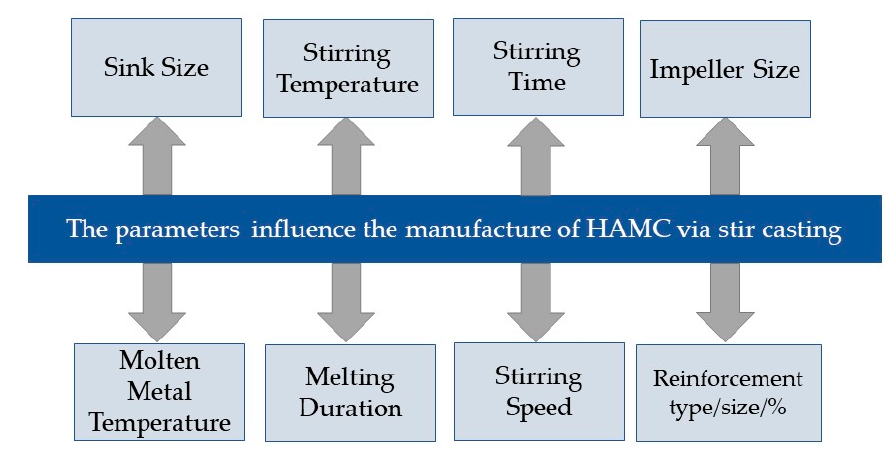
Figure 6. Factors that influence the stir casting process.